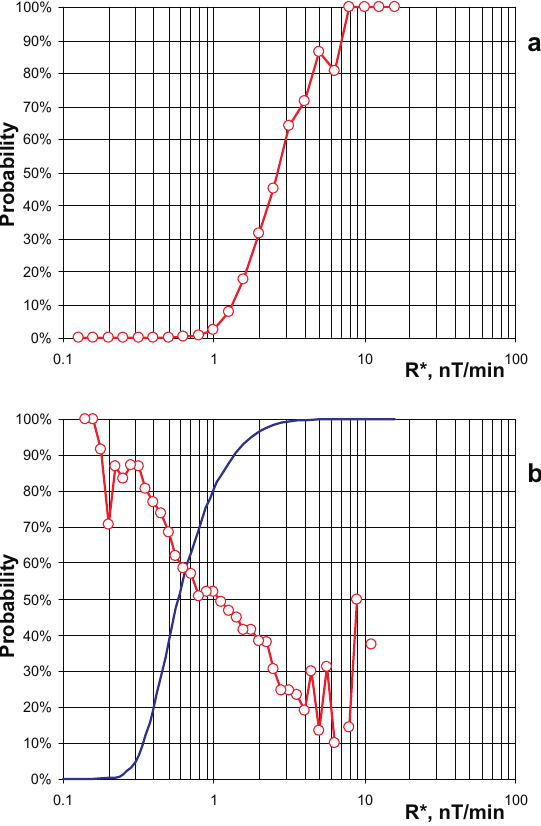
Fig. 10. Conditional probabilities for PAF (hourly variation R ∗ computed from minute values): (a) P (R ∗ (k + 1 ) > 50nT/min | R ∗ (k)) ; (b) P (R ∗ (k + 1 ) > R ∗ (k) | R ∗ (k)) , and the em- pirical distribution of R ∗ (blue line), i.e. unconditional probability P (R ∗ (k + 1 ) ≤ R ∗ ) .